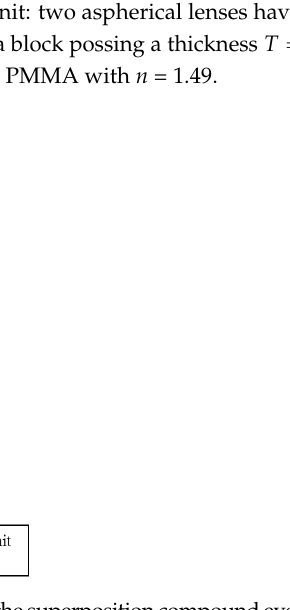
Figure 5. The structure of the primary concentrator consisting of dual-lens concentrator units and the ray-tracing simulation using LightTools TM software (Version 9.0, Synopsys, Inc., Mountain View, CA, USA), showing that a wide beam can be collected and focused into multiple narrow areas. 2.2. Secondary Concentrator: Mirror + Reflective Channel Although the beam size was scaled down in the previous simulation, the approach of using the dual-lens concentrator suffers from certain limits for a thousand CR purpose when it comes to considering both criteria of light performance and cost-related aspects. To attain at a higher CR, the single-concentrator system of this kind has more often re- quired bulky optics, which not only lend a large aberration (resulting in an extended focal spot), but also incurred the unwanted cost of the entire system, as well as not precluding the difficulty in manufacturing. To go further, we here focus on a much easier avenue: a mirror + reflective channel system, aiming to superposition all the concentrated beams to a sole place of interest, called a “secondary concentrator” for the clear reason; this system further contributes to the gain in CR. We are now equipped to implement the coincide of the discrete beam areas to remain in the small concentrating area. We then collect the light at the exit of the secondary concentrator. Coarsely speaking, we still hold the light area with the same dimension as that generated by each dual-lens concentrator unit.